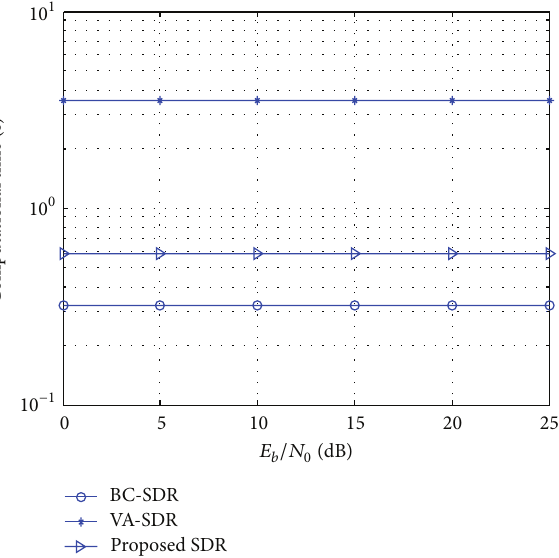
Figure 1: The BLER performance of the SDR detectors for 4×4 256- QAM MIMO systems.